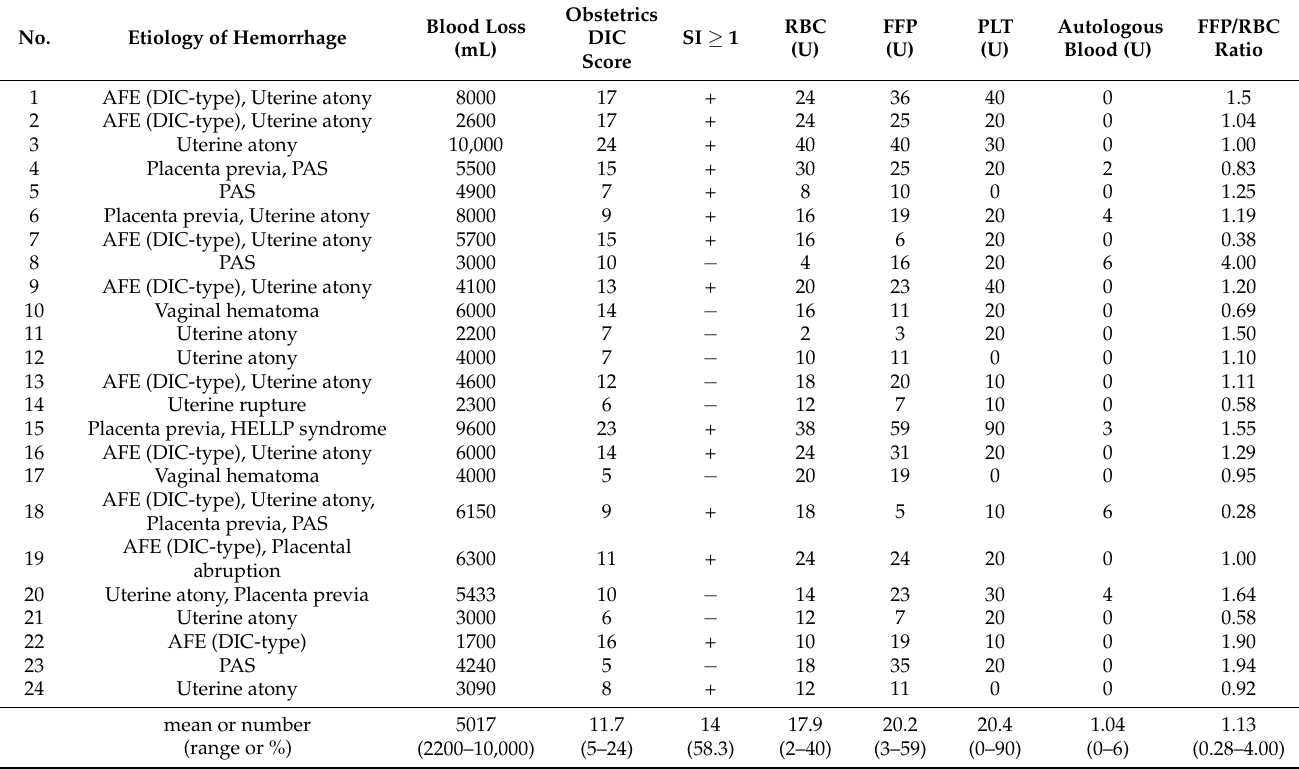
Table 3. List of patients receiving blood products for massive transfusion protocol.